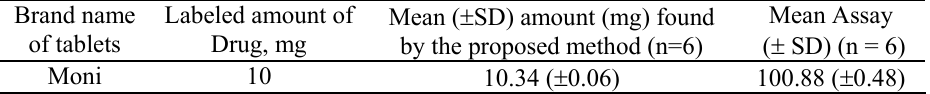
Table 4. Assay of montelukast